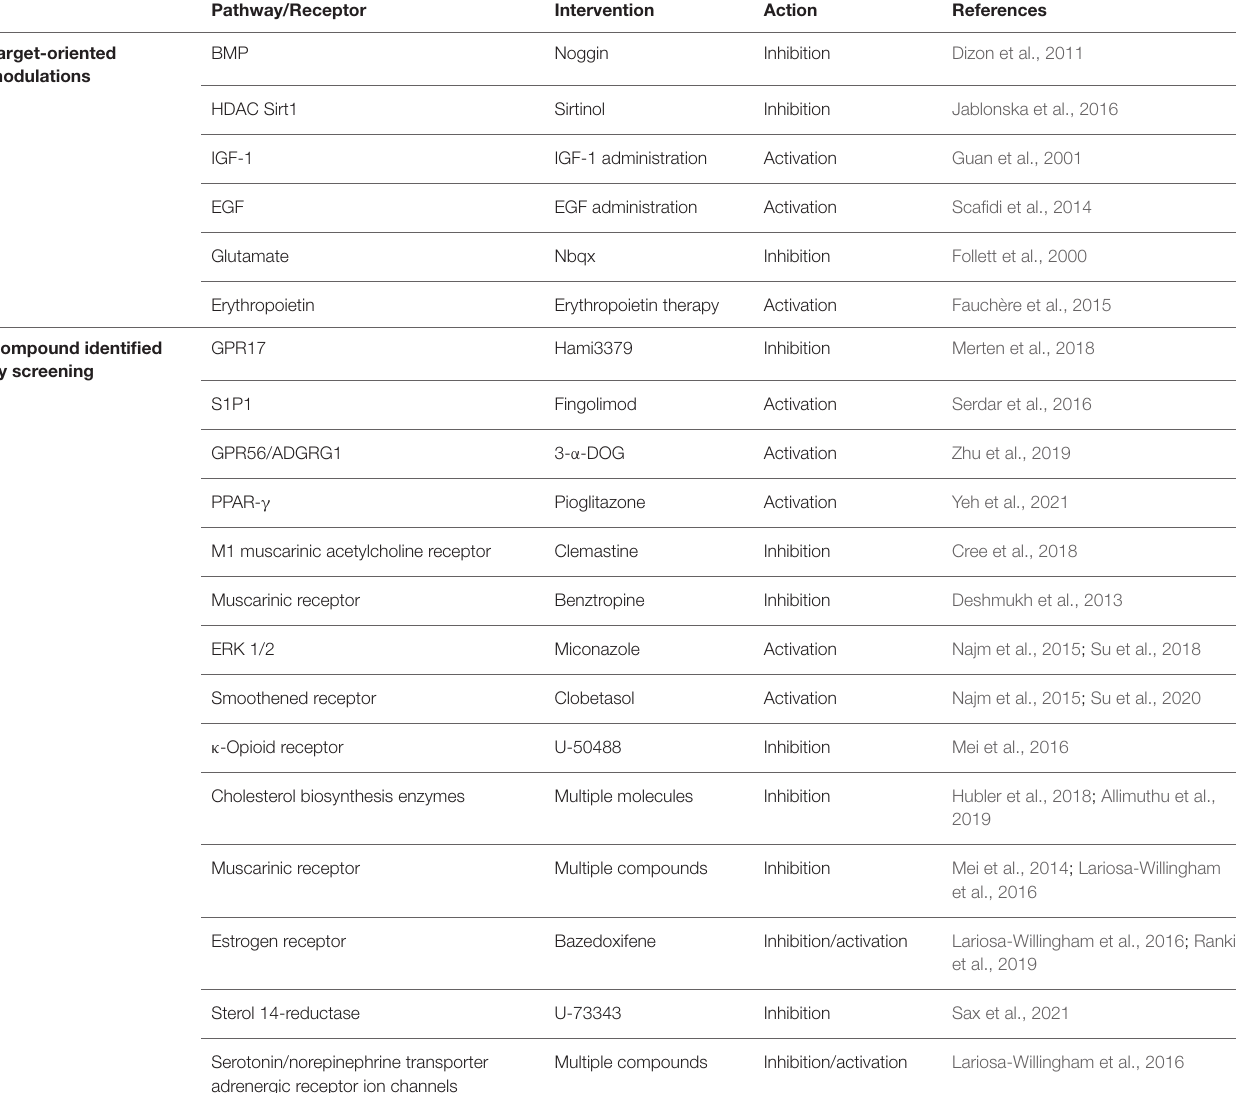
TABLE 3 | Pathways and compounds that have been investigated to enhance endogenous myelination and white matter development in perinatal